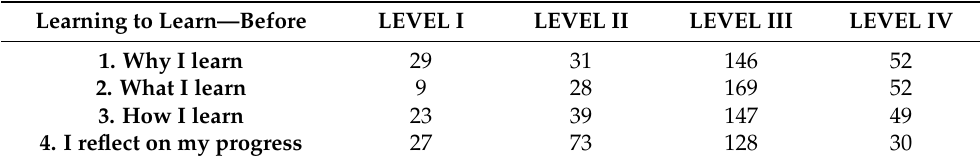
Table 2. Acquiring learning to learn competence (pre-test) by dimension and level of progression (n = 258).